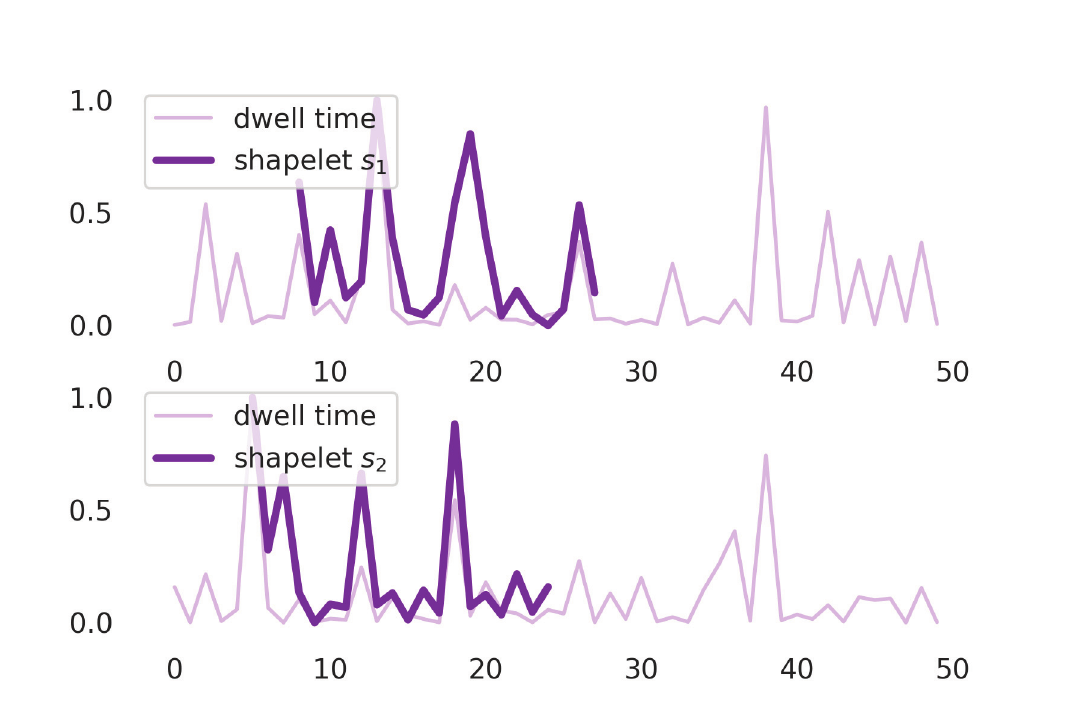
Fig 4. Two exemplary samples of dwell time series of length N = 50 obtained from the analysis of patch–clamp recordings corresponding to U m = 20 mV (upper figure) and U m = 60 mV (lower figure) and the same naringenin concentration [Nar] = 10 μM . Both sequences are presented alongside with the shapelets s 1 , s 2 found by the machine learning algorithm of length 20 which best match the shape of